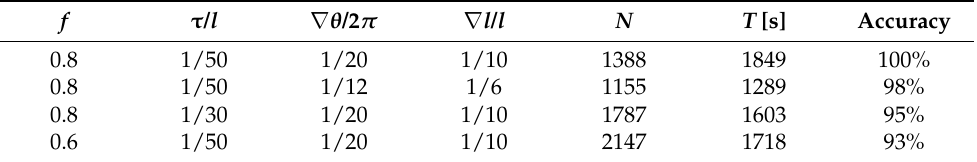
Table 1. The statistics of the algorithm with different parameter settings ( f = fraction of the points of floe X , τ = threshold of the Hausdorff distance, l = circumscribed circle diameter of floe X , ∇ θ = step size of rotation, ∇ l = step size of translation, N = number of matched floes pairs, T = computing time. Accuracy is the percentage of correct